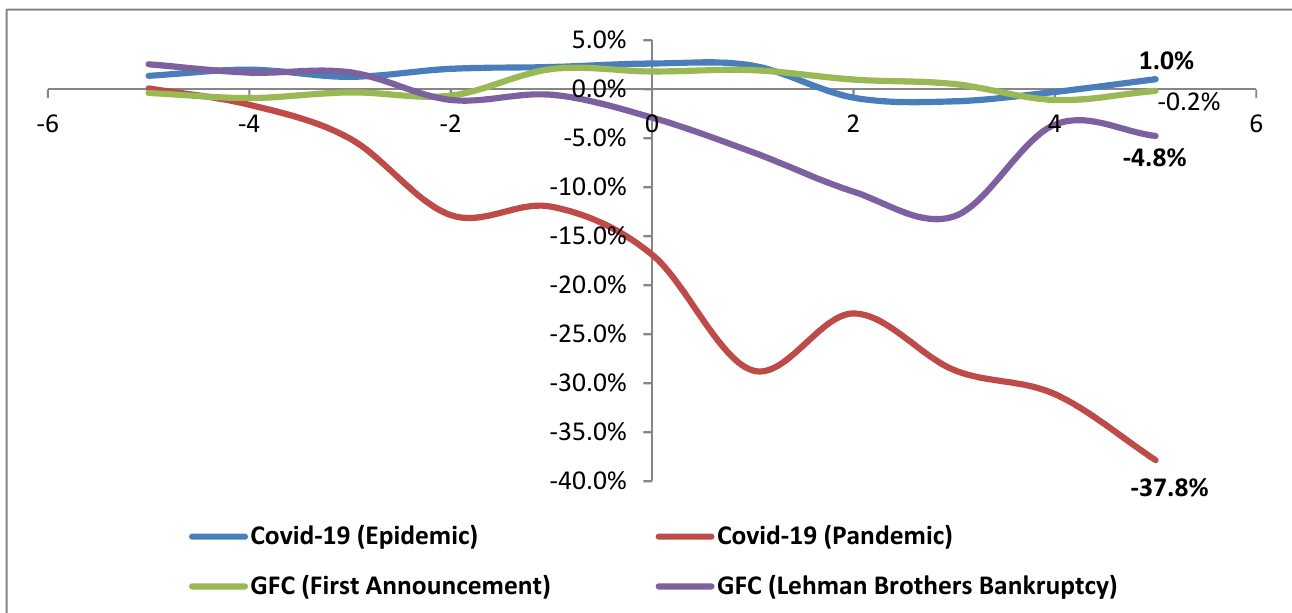
Figure 3. The BUX Cumulative Abnormal Return in the COVID ‐ 19 Outbreak and Global Financial Crisis. Figure 3 chart line of cumulative abnormal return of BUX for COVID-19